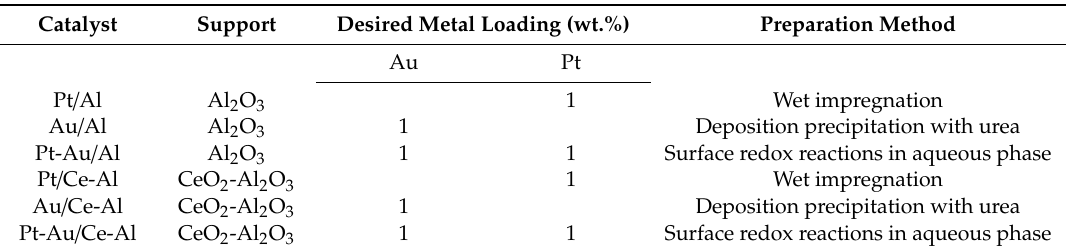
Abbreviations, desired metal loadings, and the used preparation methods for the studied